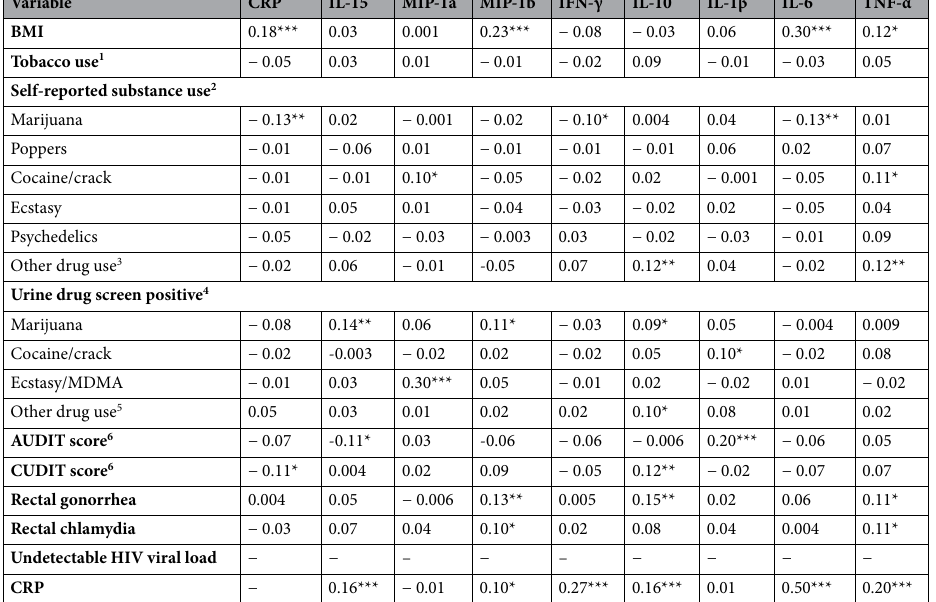
Table 3. Correlations between inflammatory cytokines, CRP, and various substances among HIV-negative participants, RADAR, Chicago, 2015–2017. *p < 0.05; **p < 0.01; ***p < 0.001. 1 In the past 30 days. 2 In the past six months, only those self-reported use ≥ 4%. 3 Substance with < 4% self-reported use in the sample: methamphetamines, synthetic marijuana, ketamine, GHB, inhalants, heroin. 4 Note: urine drug screens unavailable for poppers and psychedelics. 5 Other urine drug screens include: benzodiazepines, amphetamines, methamphetamines, opiates. 6 Based on the Alcohol Use Disorders Identification Test (AUDIT) and Cannabis Use Disorders Identification Test (CUDIT) scoring methods; higher score indicates higher risk alcohol use.